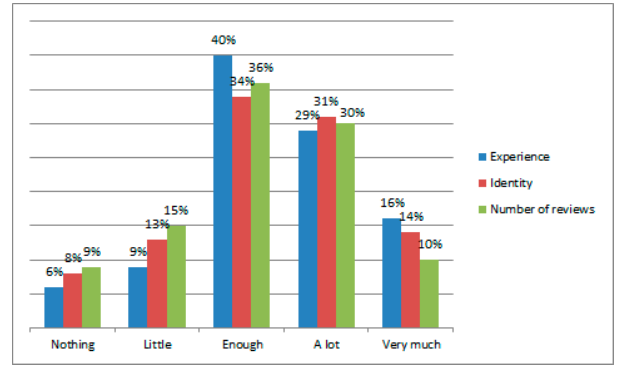
Figure 3. Advisor variables affecting trust of online reviews.